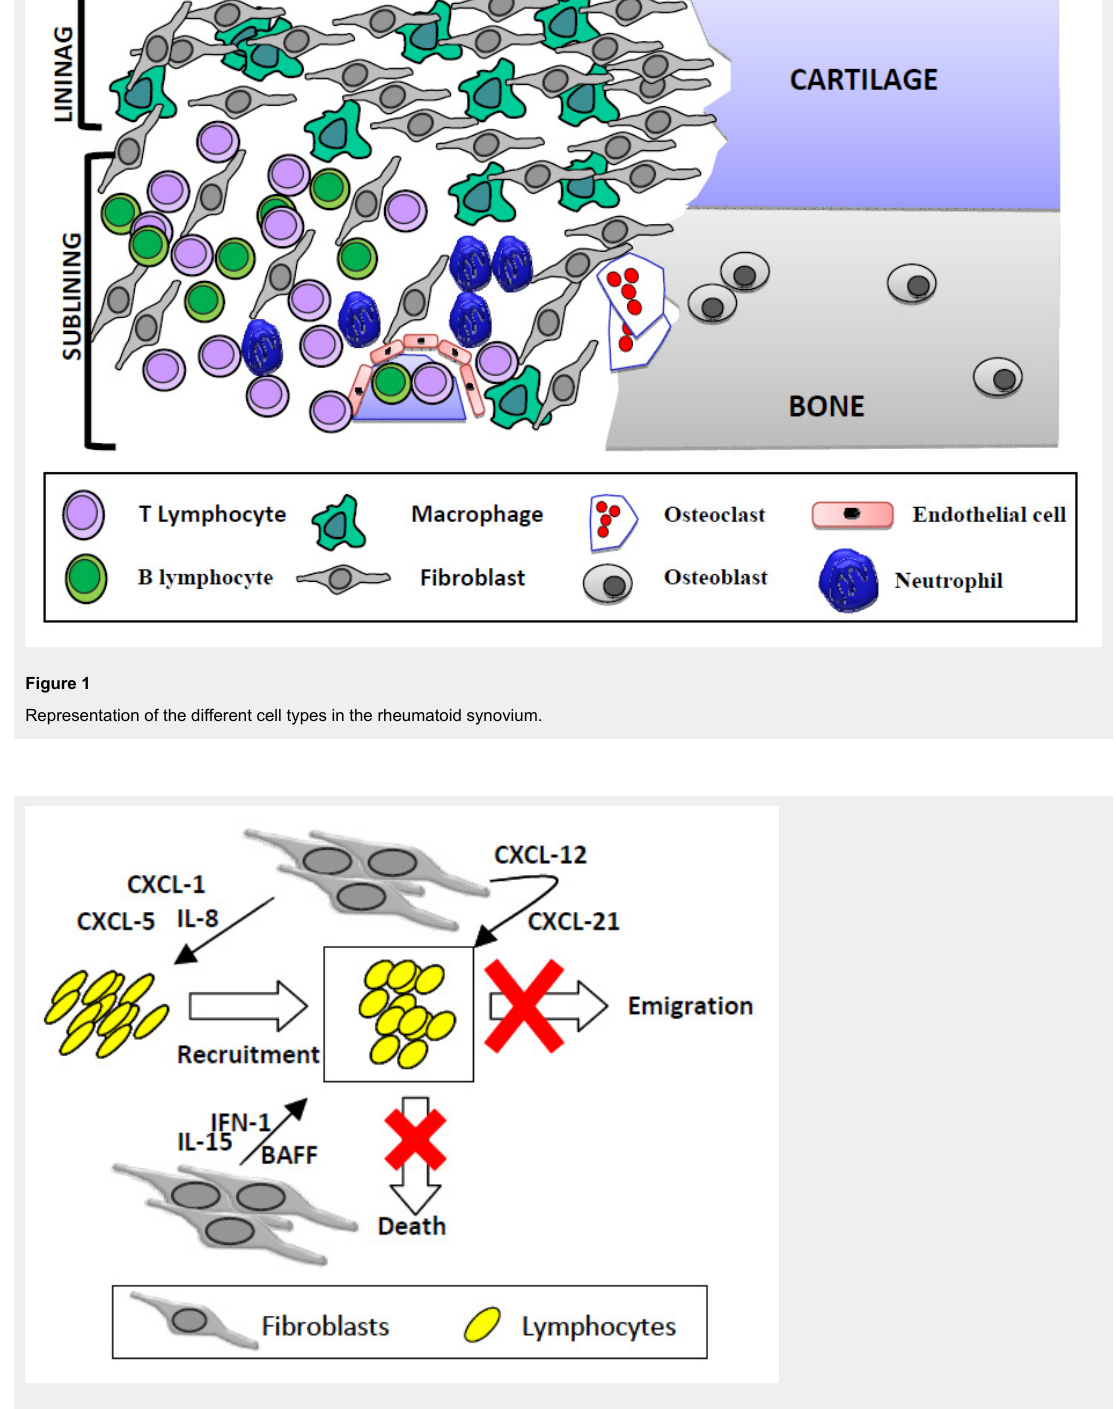
Figure 2 Fibroblasts orchestrate chronic inflammation in RA. The maintenance of persistent leukocyte infiltrates results from a distorted homeostatic balance between leukocyte recruitment, proliferation, emigration and death. Activated RASFs produce inflammatory chemokines (IL-8, CXCL5, CXCL1) implicated in leukocyte recruitment to diseased synovium, survival factors (type I interferon, IL-15, BAFF) and constitutive chemokines (e.g. CXCL12, CCL21). The net result is the chronic accumulation, survival and retention of leukocytes at sites of